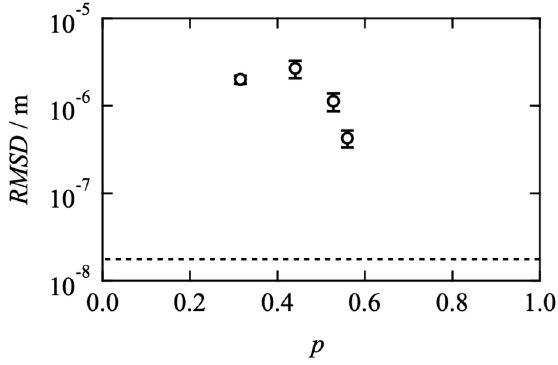
Figure 6. Root-mean-square distance the prepolymers diffuse during the viscoelastic relaxation time ( RMSD ) as a function of p . The dashed line represents the gyration radius of a four-armed precursor chain.